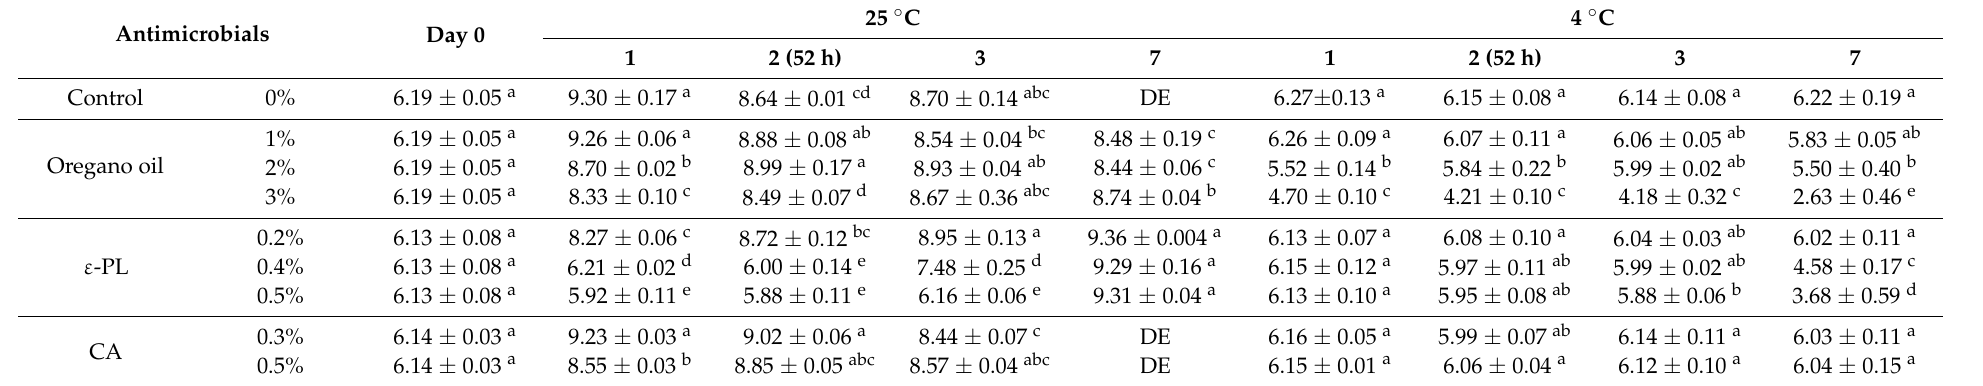
Table 4. Antimicrobial activity of oregano oil, ε -PL and CA against S. montevideo CICC 21588 in diluted tahini at 25 ◦ C or 4 ◦ C.